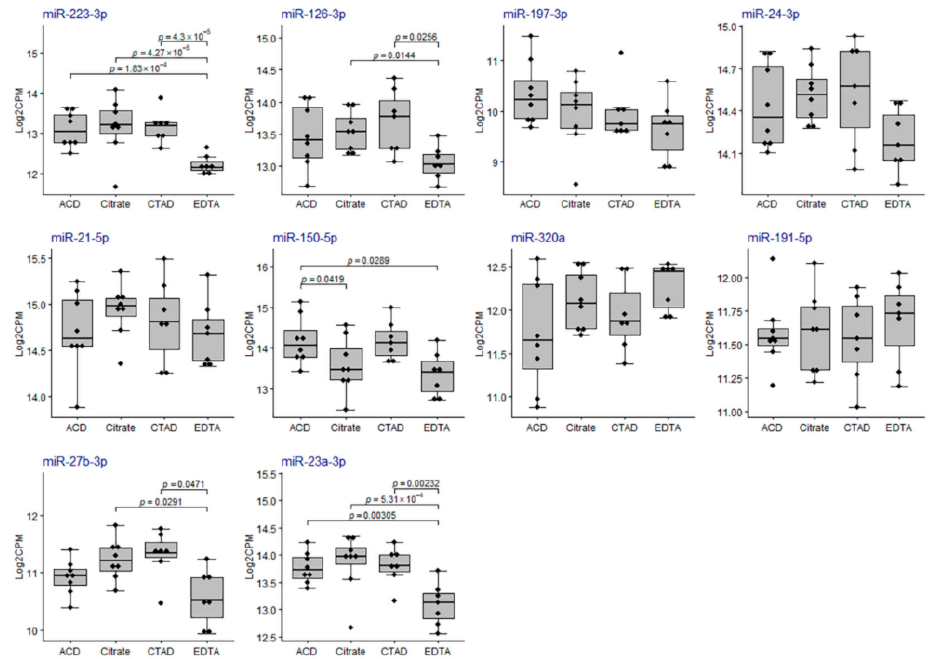
Figure 10. The distribution of miRNA expression for the top ten platelet-derived miRNAs in the study sample groups. On the y -axis, TMM-normalized log 2 CPM values are shown. The boxplots represent median and interquartile ranges (IQRs) in the box and values for individual samples in the dots. p -values of statistical significance for the pairwise quasi-likelihood F-test comparisons performed in EdgeR are provided on the plots for each pair of the study groups with p <